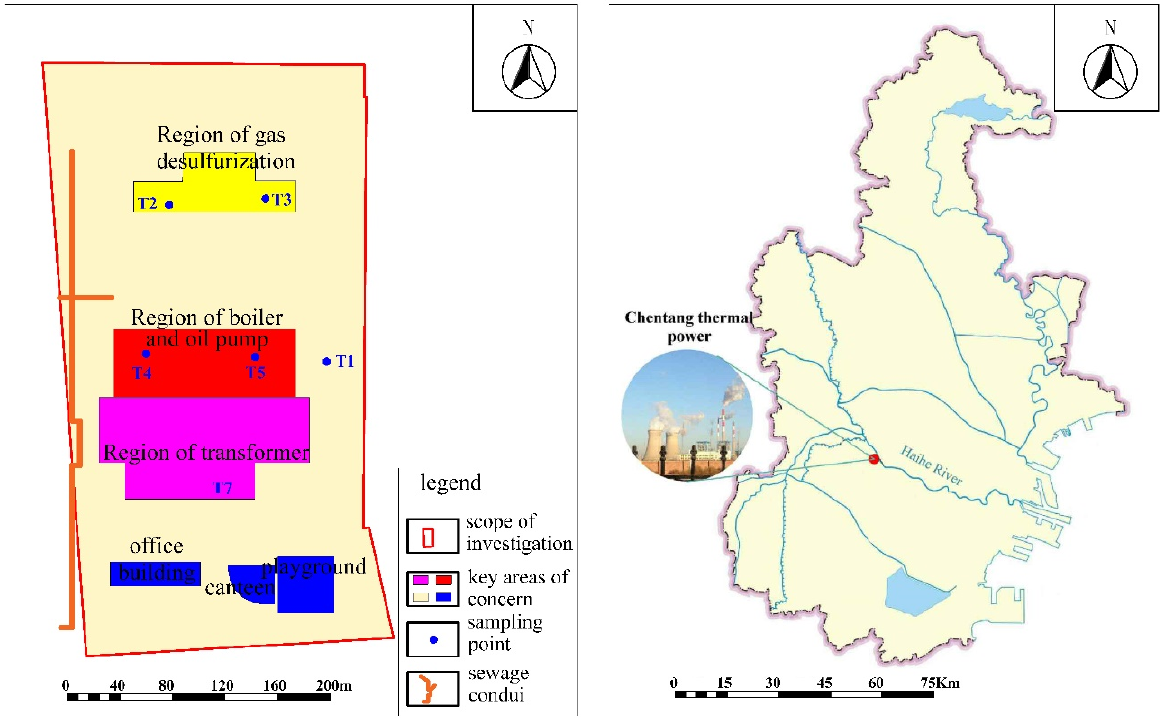
Figure 1. Locations of core sampling sites at the thermal power plant legacy site, Tianjin, China.